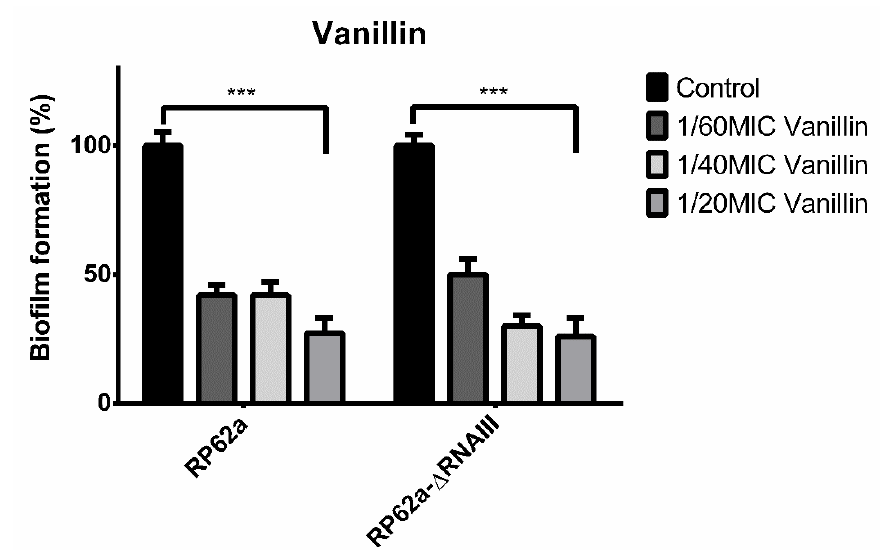
Figure 4. Inhibition effect of vanillin on the biofilm formation of S. epidermidis RP62a and RP62a- ∆ RNAIII in all three used sub-inhibitory concentrations compared to the non-treated control (*** p < 0.001).